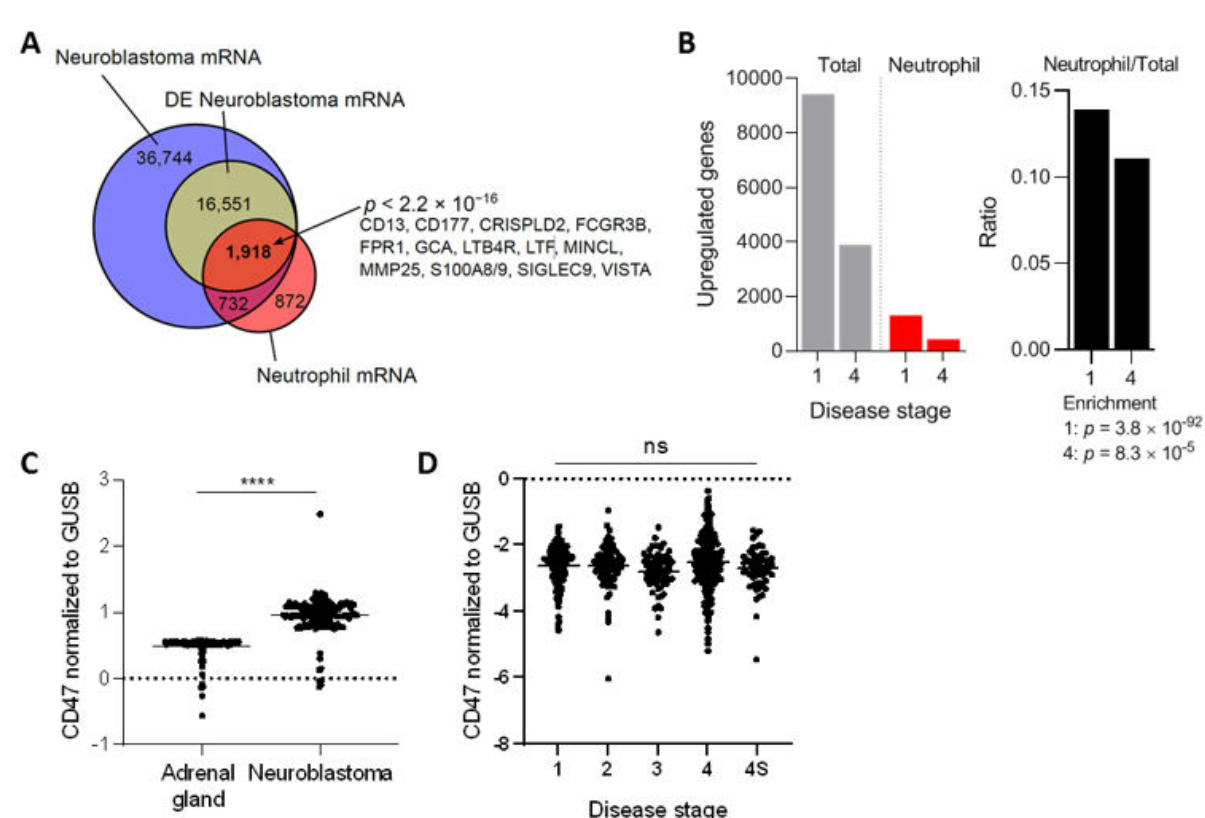
Figure 1. ( A ) Venn diagram showing overlap between neuroblastoma (Zhang et al. [39]) and neutrophil (Grassi et al. [40]) regulated transcripts. Overrepresentation was determined with a Fisher exact test. DE, differentially expressed. ( B ) Proportion of neutrophil associated genes in neuroblastoma stratified according to disease stages 1 and 4 (left panel: absolute numbers, right panel: ratios). Enrichment determined with Fisher exact tests. ( C ) Normalized CD47 mRNA expression levels in healthy adrenal gland and neuroblastoma tumors. Adrenal gland: n = 127, neu- roblastoma: n = 162. Statistical significance was tested with unpaired t -test; **** p < 0.0001. ( D ) Normalized CD47 mRNA expression levels in neuroblastoma patients stratified by disease stage. Stage 1: n = 121, stage 2: n = 78, stage 3: n = 63, stage 4: n = 183, stage 4S: n = 53. Statistics were performed by one-way ANOVA; ns, not